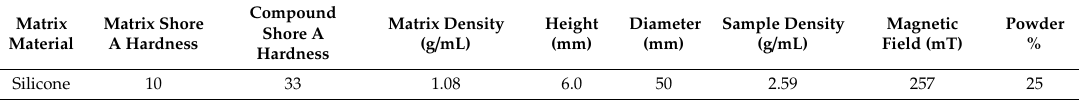
Table 1. MRE sample characteristics.